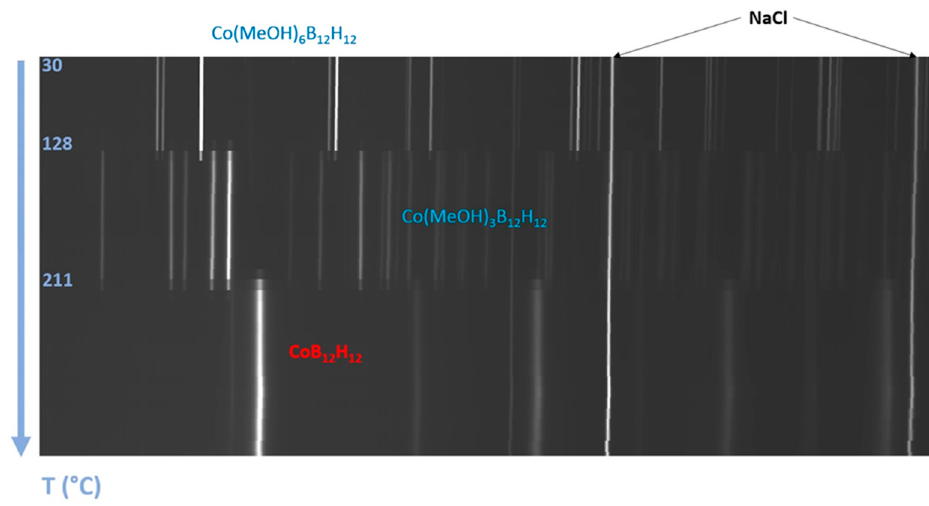
Figure 4. Temperature dependent X-ray powder diffraction patterns (T-ramp) for ball-milled Na 2 B 12 H 12 + CoCl 2 mixture loaded with methanol (heating rate 10 K/min under dynamic vacuum, λ = 0.77936 Å).